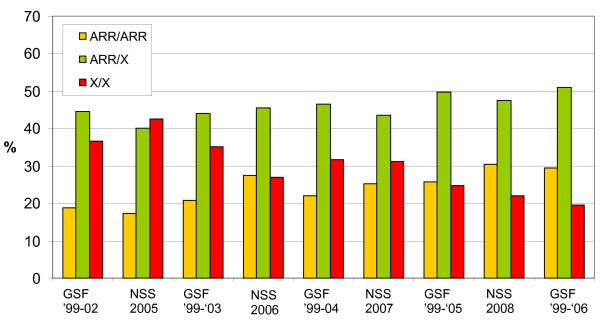
Alignment of GSF and NSS genotyping samples. The average ARR homozygote (ARR/ARR), heterozygote (ARR/X), and non-ARR (X/X) frequencies in the NSS sample, which only contains animals over 18 months of age, was aligned with the GSF sample by exclusion of the birth cohorts which are not present in the NSS sample. In detail: the NSS of 2008 (of animals over 18 months) does not contain animals from the 2007 birth cohort; the NSS of 2007 does not contain animals from the 2006 and 2007 birth cohorts; etc. GSF '99-02: genotype frequencies of birth cohorts 1999 - 2002; GSF '99-03: genotype frequencies of birth cohorts 1999 - 2003; etc. NSS 2005: genotype frequencies of the National Surveillance Sample from 2005; NSS 2006: genotype frequencies of the National Surveillance Sample from 2006; etc.